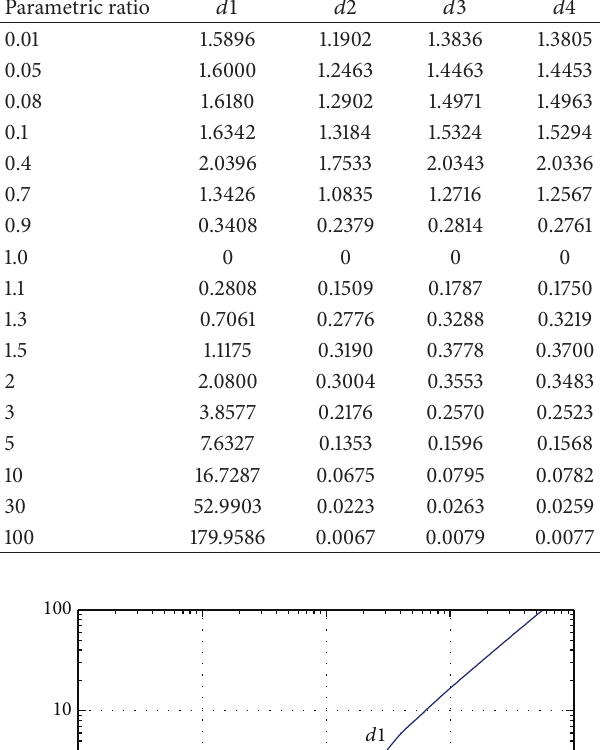
Table 4: Distances between 𝑅 2 and 𝐶 1-loci with respect to different fault models.